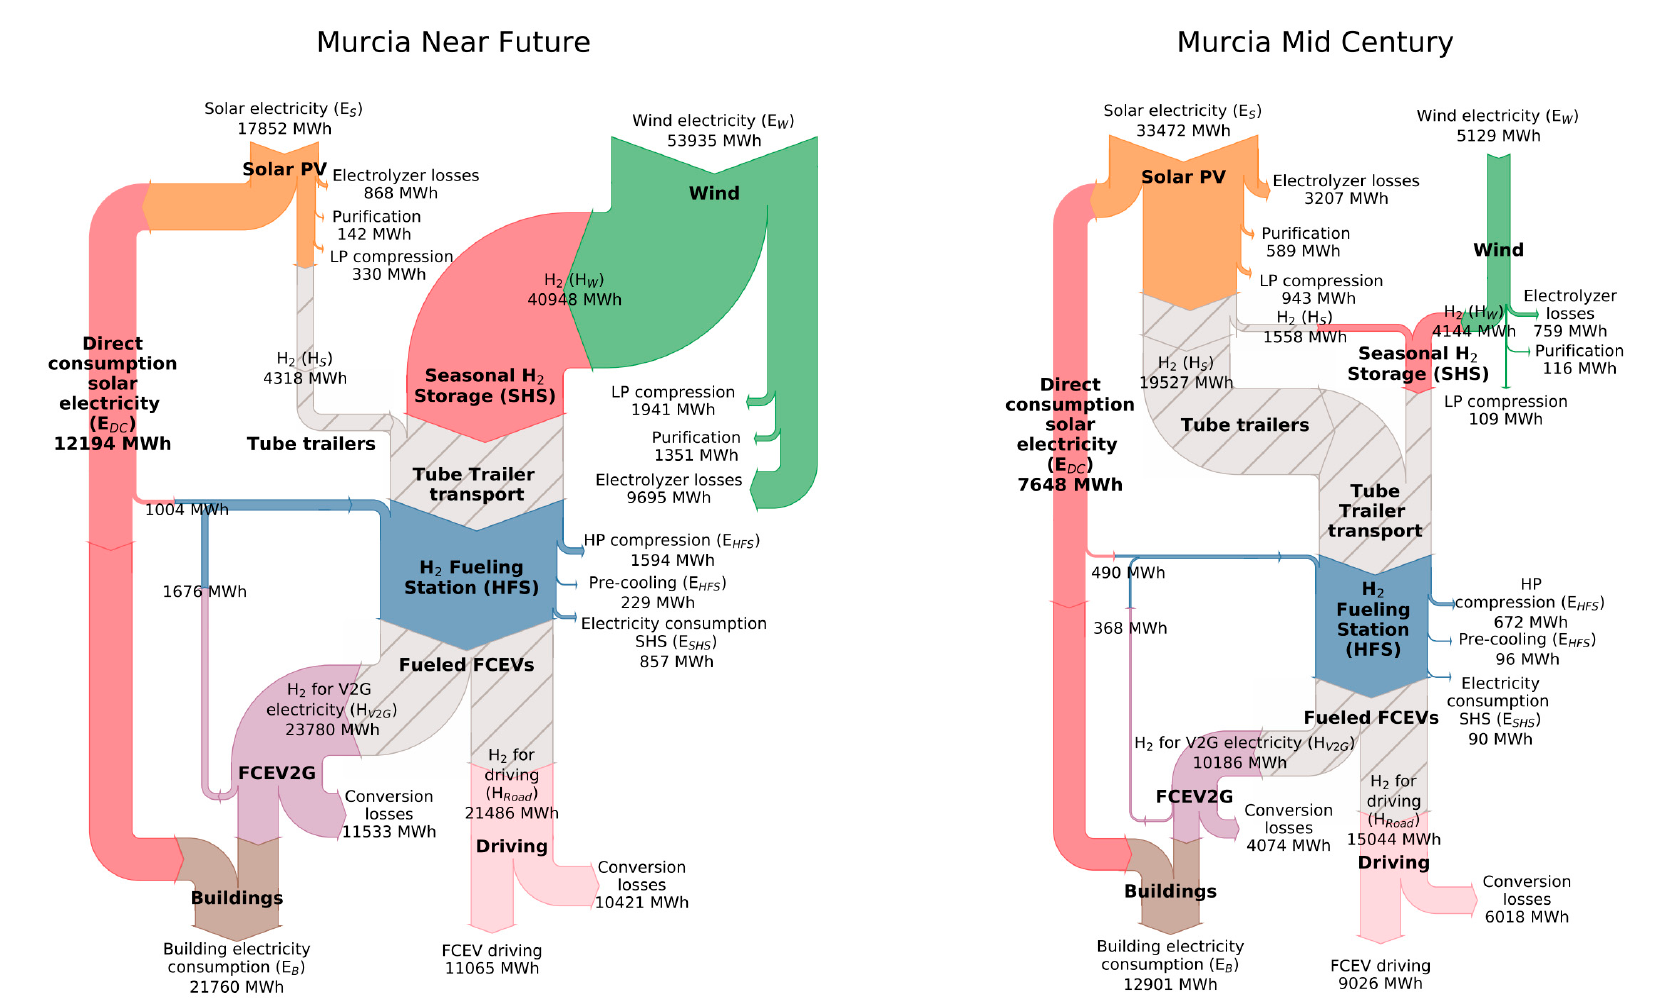
Figure 5. Annual energy balance for Murcia for the Near Future scenario (left) and the Mid Century scenario (right).